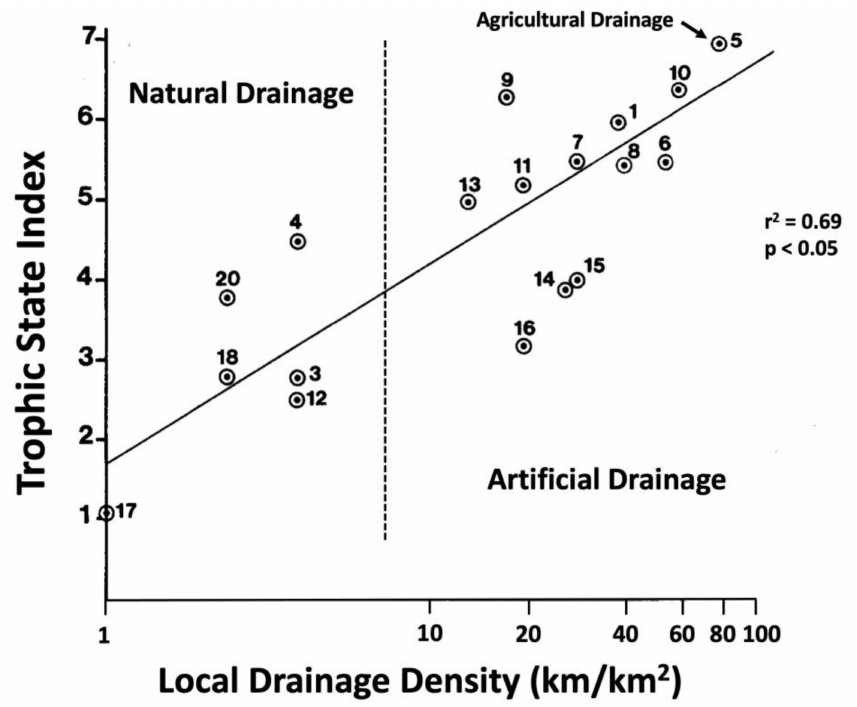
Figure 6. Local drainage density versus trophic status of stations in the Barataria Basin (modified from [42]; data collected 1977–1978).